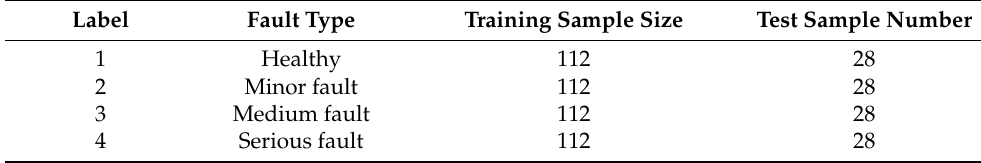
Table 4. Experimental data sheet.